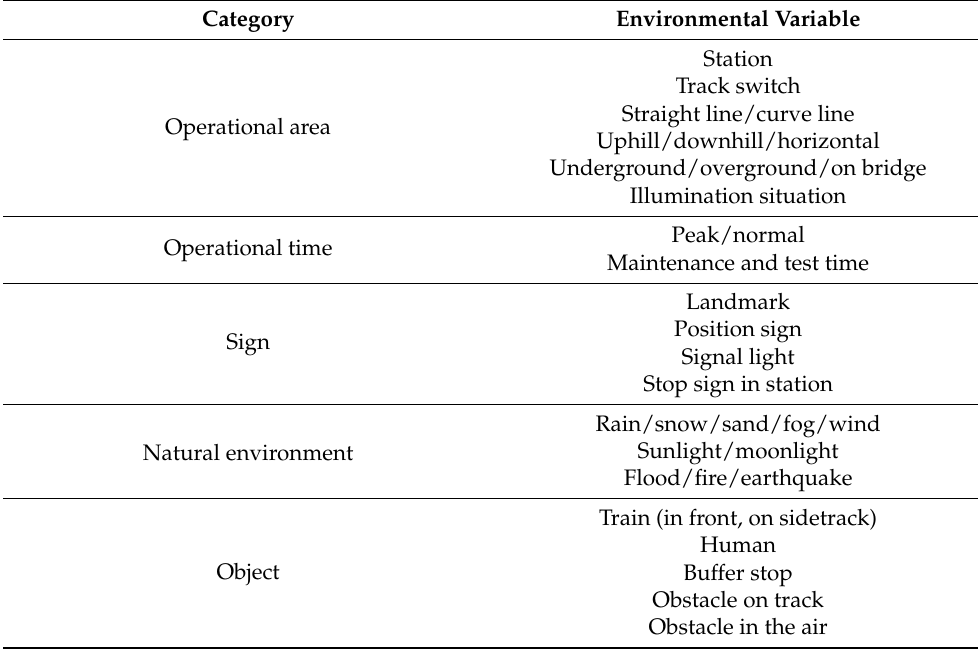
Table 1. Environmental variables in the operational environment of the